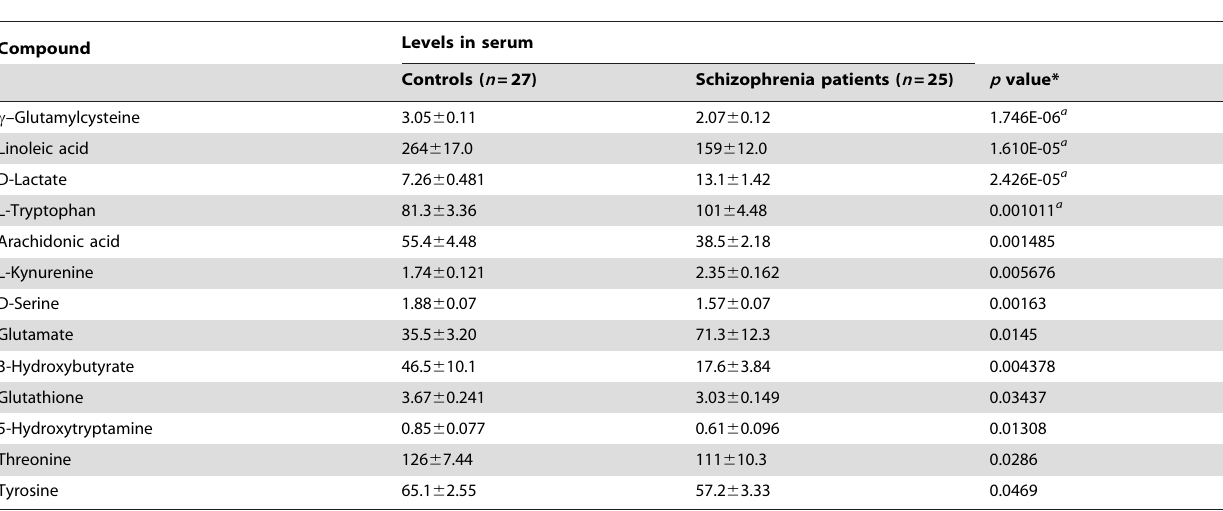
Table 2. Serum levels of metabolites ( m mol/L) that were differentially expressed between controls and schizophrenia patients.